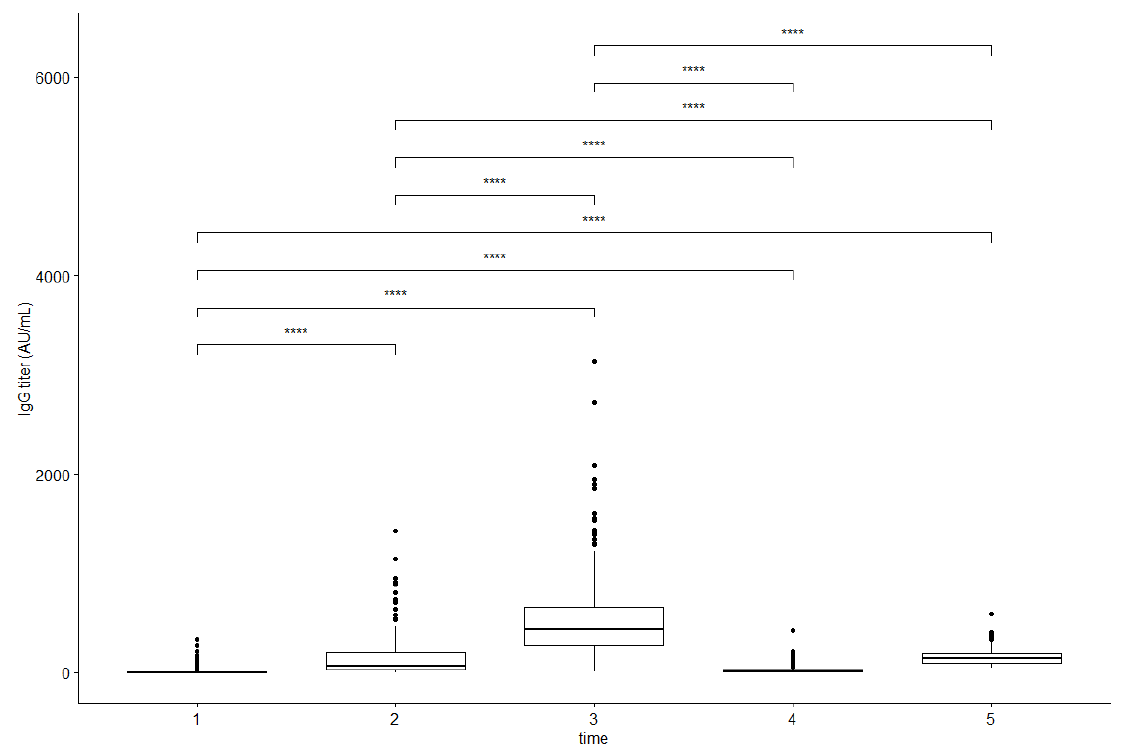
Figure 2. Changes in the anti-SARS-CoV-2 IgG titers over time: before the first dose (1), on the day of receiving a second dose, before the shot (2), 14 days after receiving the second dose (an early follow-up) (3), 8 months after complete inoculation (a long-term follow-up), before receiving a booster injection (4), and 21 days after receiving a booster dose (5). Abbreviations: ****— p < 0.001 for paired multiple comparison tests.